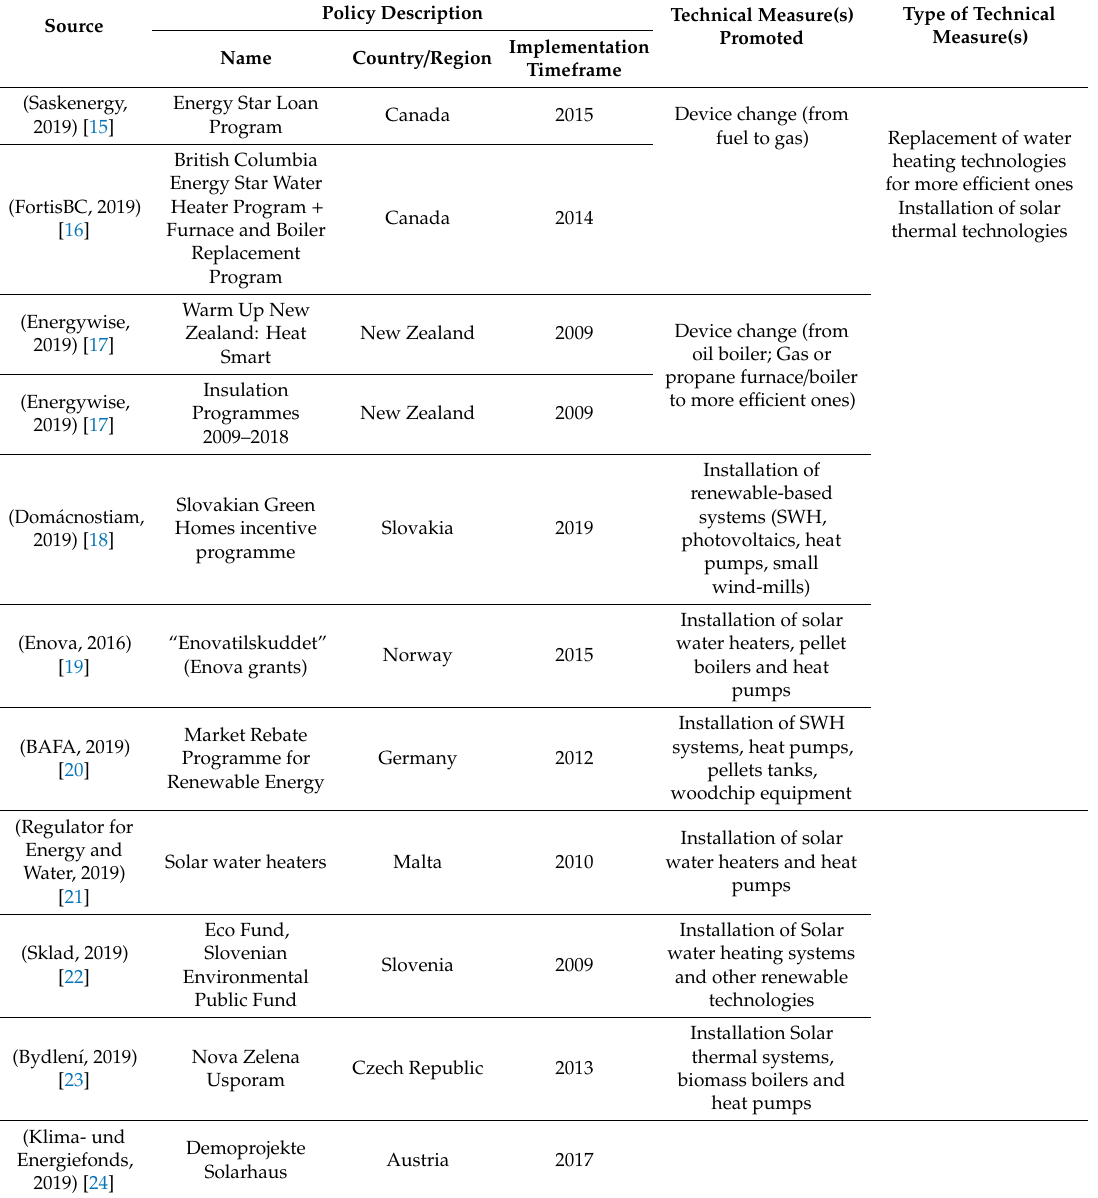
Table 2. List of technical measures, type and source of